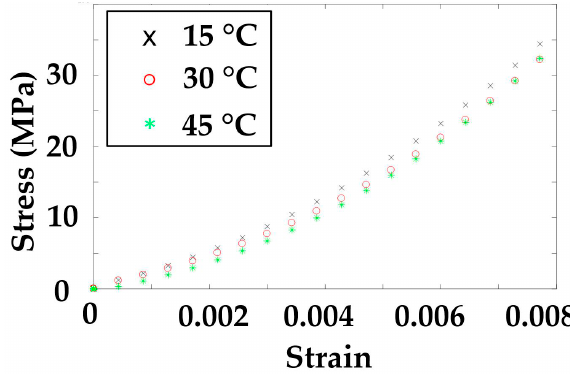
Figure 11. Axial stress–strain curves at three temperatures.